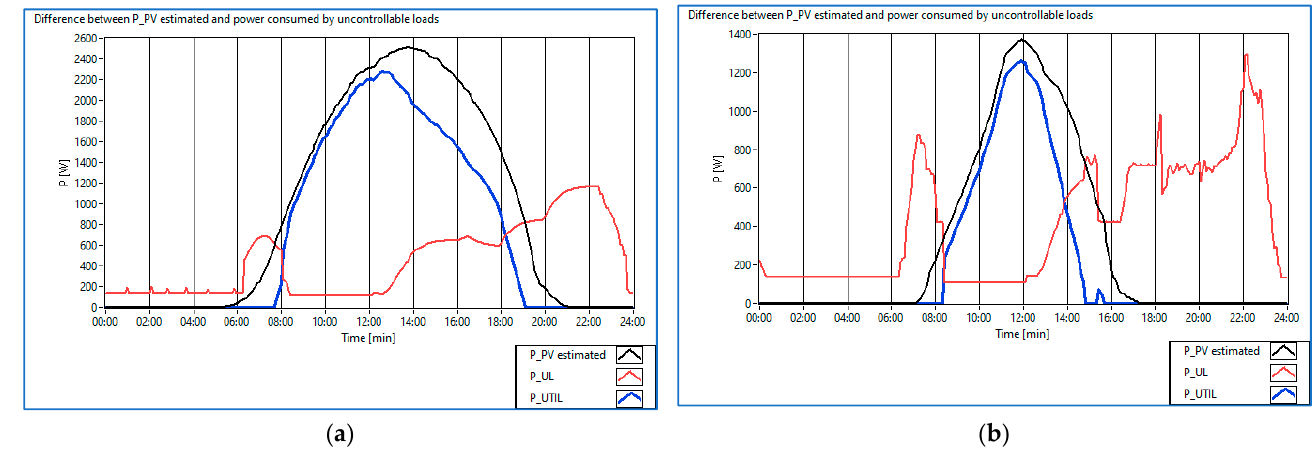
Figure 8. P PV estimated by RBF, P UL , DP PV1 for: ( a ) scenario 1; ( b ) scenario 2.